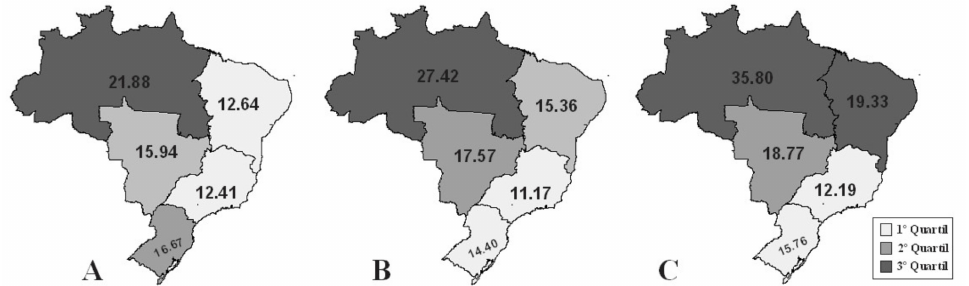
Figure 2. Quartiles of cervical cancer mortality rates in the Brazilian regions in the periods observed. ( A )